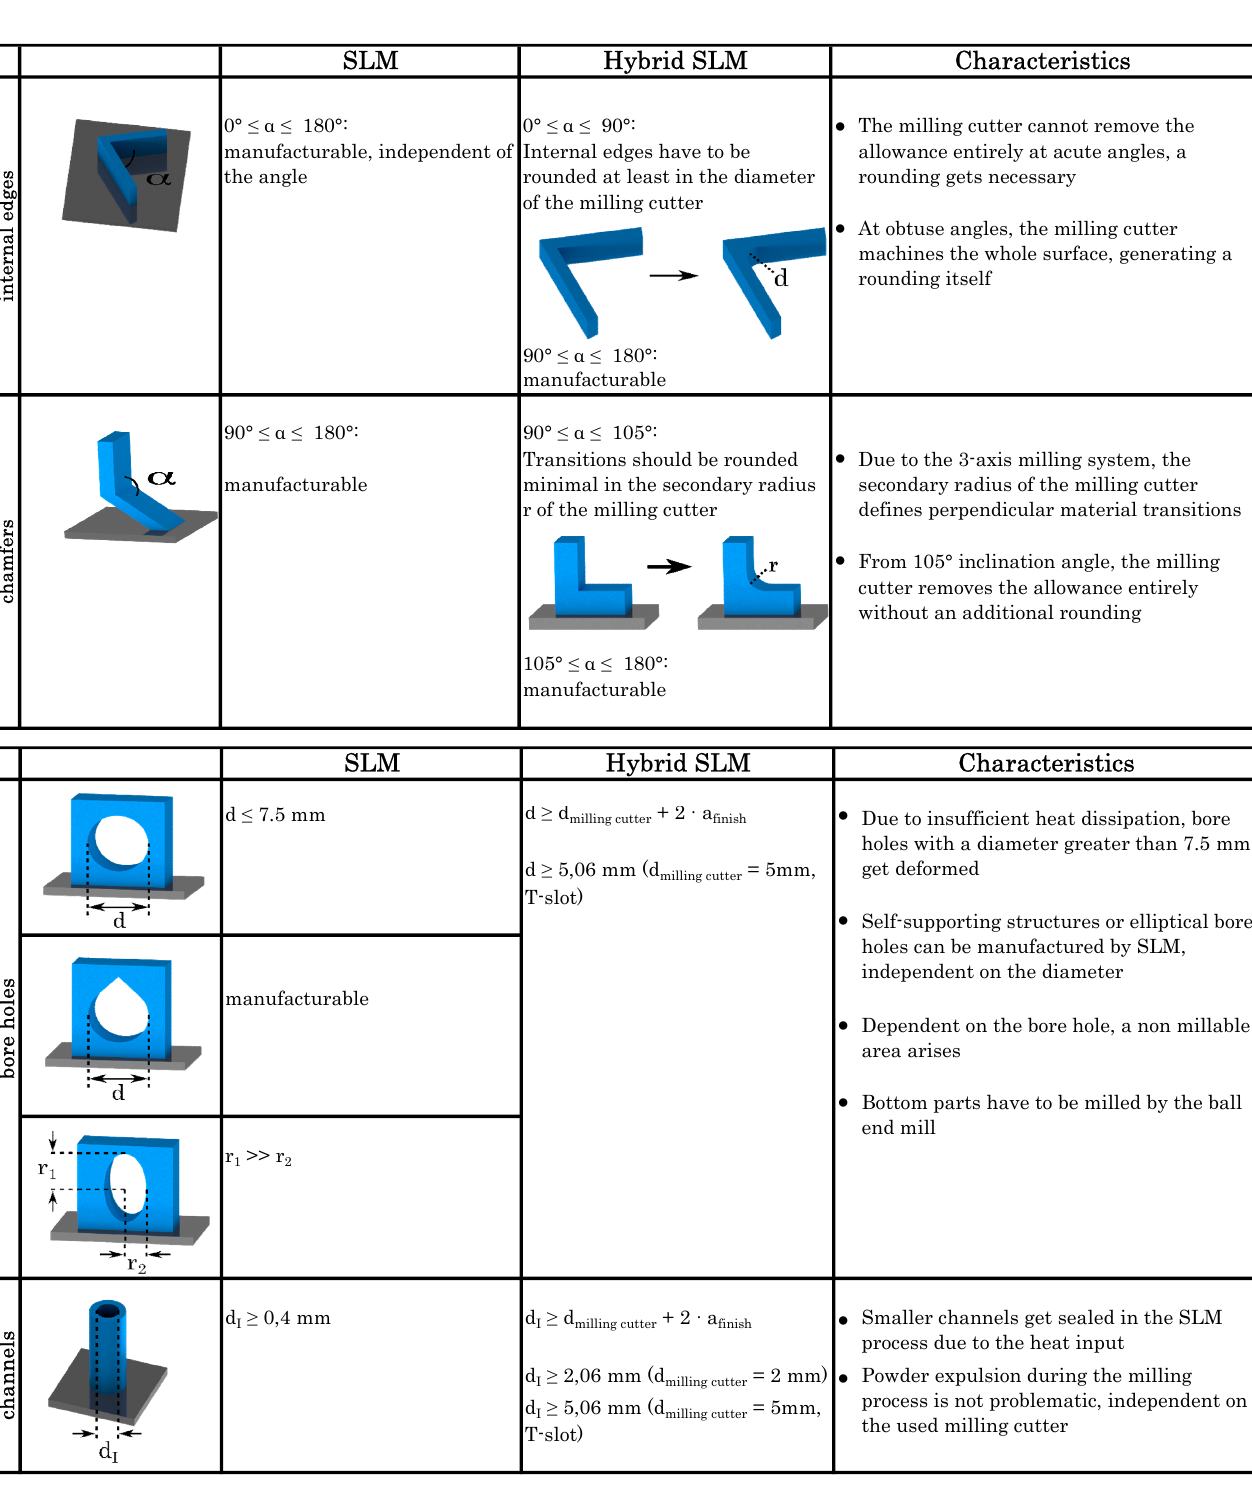
Figure A1. Design Guideline for the sole SLM and the hybrid additive